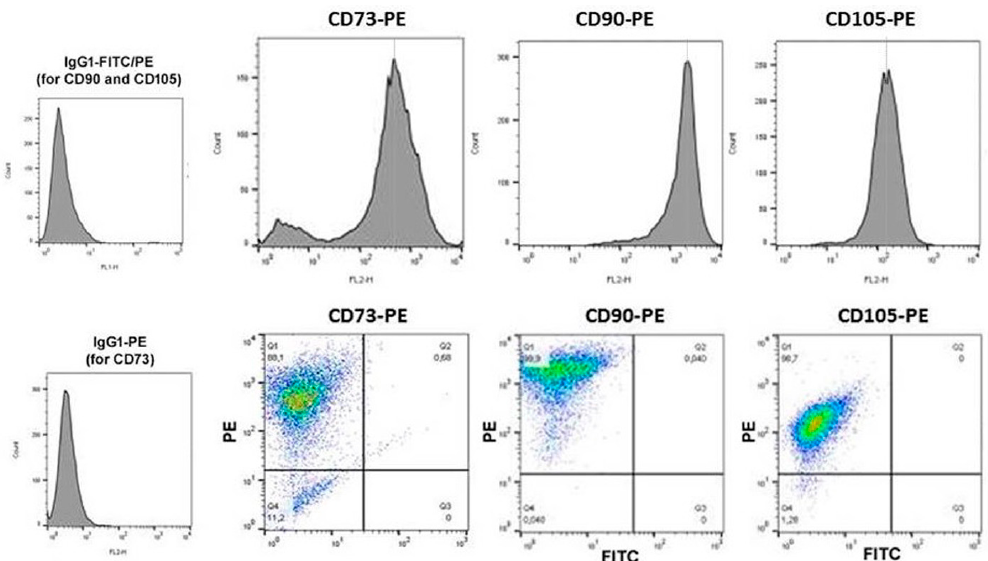
Figure 1. Expression of typical mesenchymal stroma / stem-like cells (MSC) markers in MSC544. Isolated human MSC544 from a patient with a benign phyllodes tumor were long-term cultured (until P15 (for CD73) and P22 (for CD90 and CD105)), whereby the presence of surface markers that are associated with a mesenchymal stroma- / stem-like cell phenotype could be characterized.